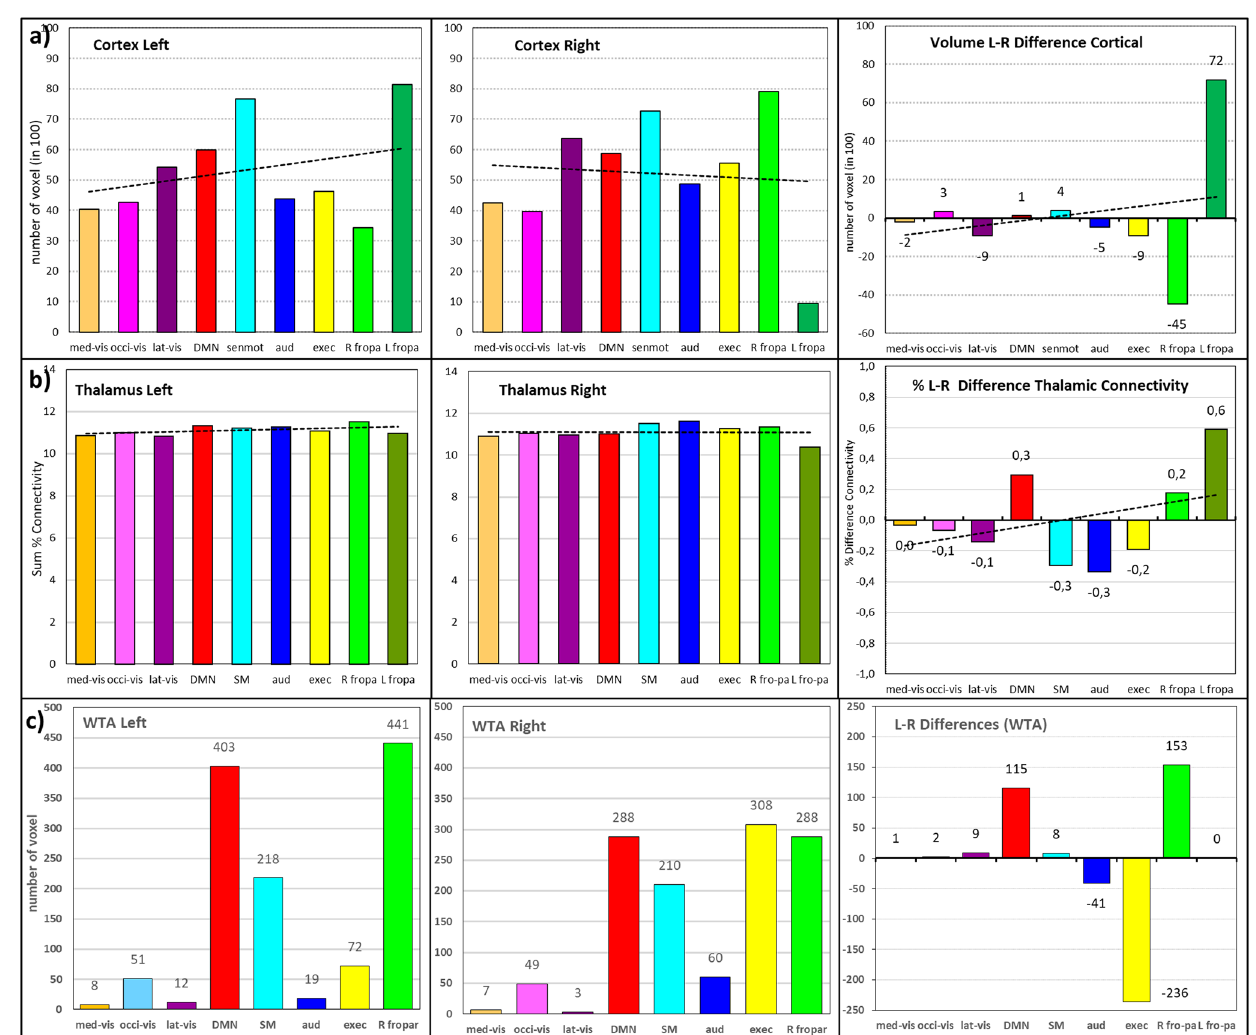
Fig. 7 Hemispheric comparison. a Number of voxels and L – R difference of nine cortical RSN (number of voxels in 100); b Hemispheric distribution and L – R differences of thalamic connectivity in percent; c Max, mean and minimum of hemispheric distribution and L – R differences of connectivity of all thalamic